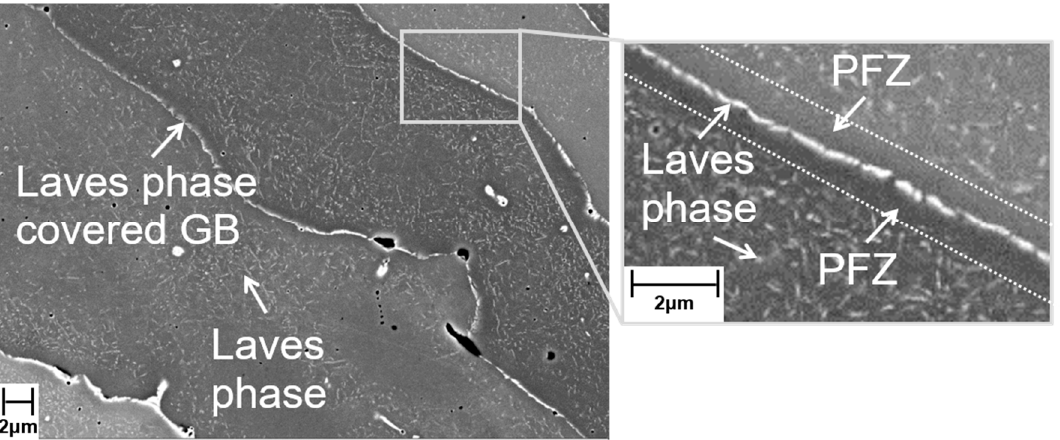
Figure 21. Microstructure characteristics of LMD-manufactured HiperFer AM (process parameters given in Table 4).